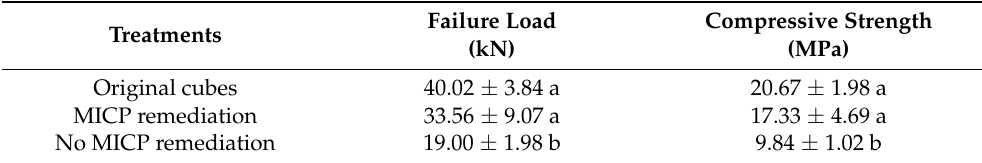
Figure 3. Cubes before and after compression strength test. The three photos at the top display the cubes prior test, the three at the bottom are the cubes after the test. Table 2. Failure load and compression strength for the MICP-treated and untreated cubes with simulated